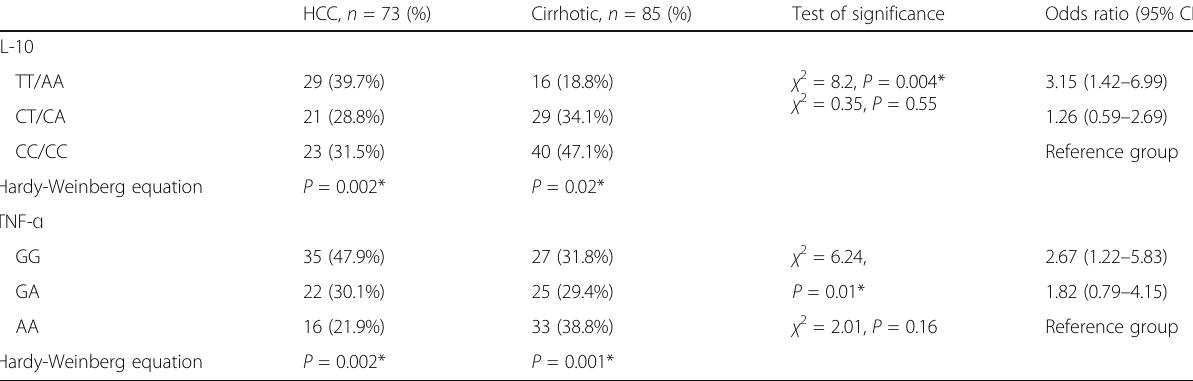
Table 3 Genotype distribution among the studied groups